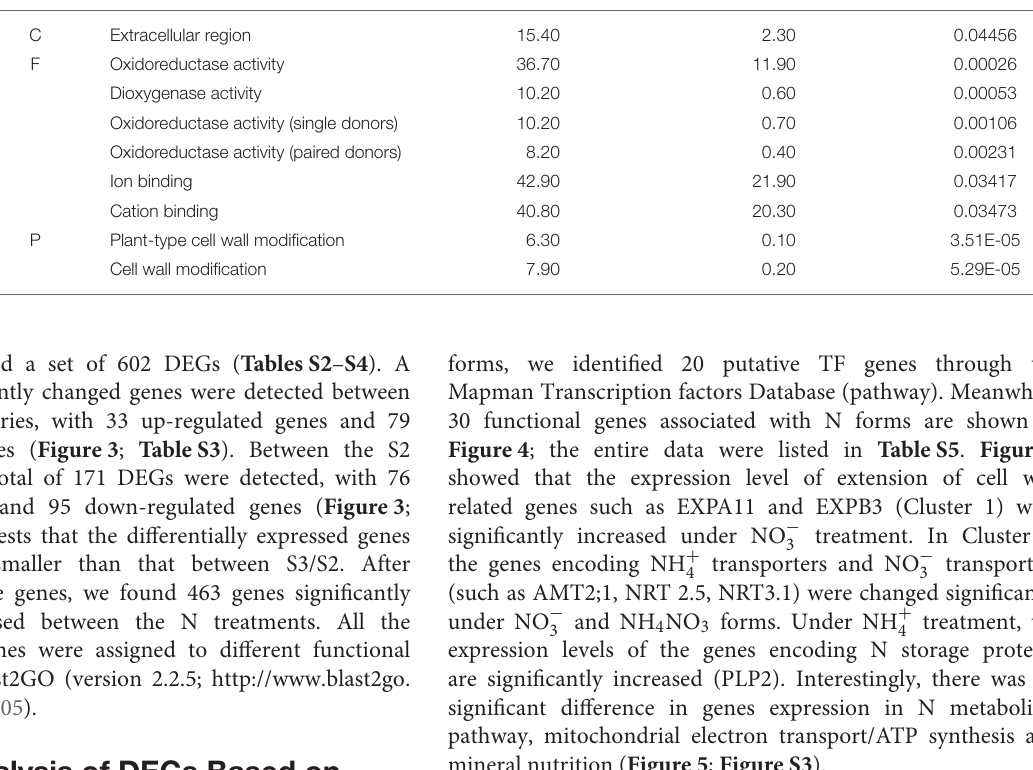
TABLE 3 | Summary of significantly over-represented functional groups in ammonium-regulated and nitrate-regulated gene sets. Nitrogen